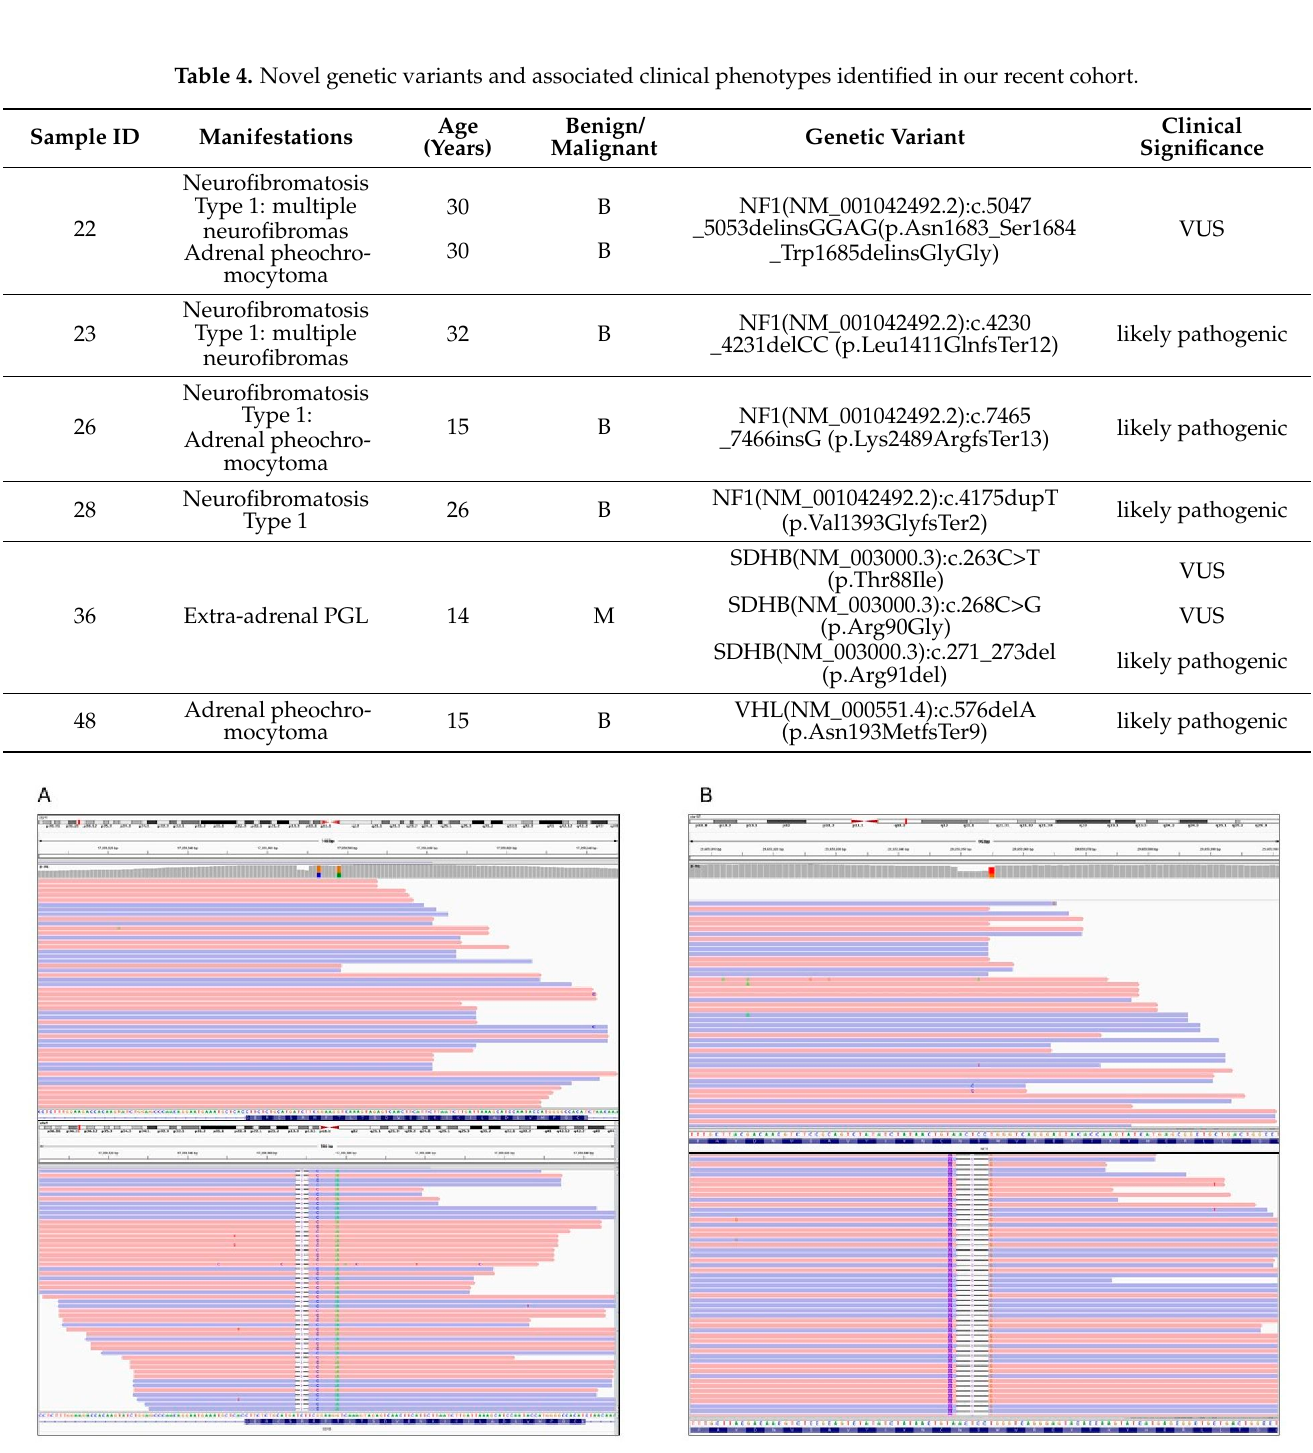
Schematic presentation of sequencing reads containing the variants SDHB(NM_003000.3):c.263C>T (p.Thr88Ile), SDHB(NM_003000.3):c.268C>G (p.Arg90Gly), SDHB(NM_003000.3):c.271_273del(p.Arg91del) (Case 38, ( A )) and NF1(NM_001042492.2):c.5047_5053delinsGGAG(p.Asn1683_Ser1684_Trp1685delinsGlyGly) (Case 24, ( B )). Each line represents one read. Half of the reads shows normal sequence ( upper part ) and half of the reads ( lower part ) show the mutated sequences.